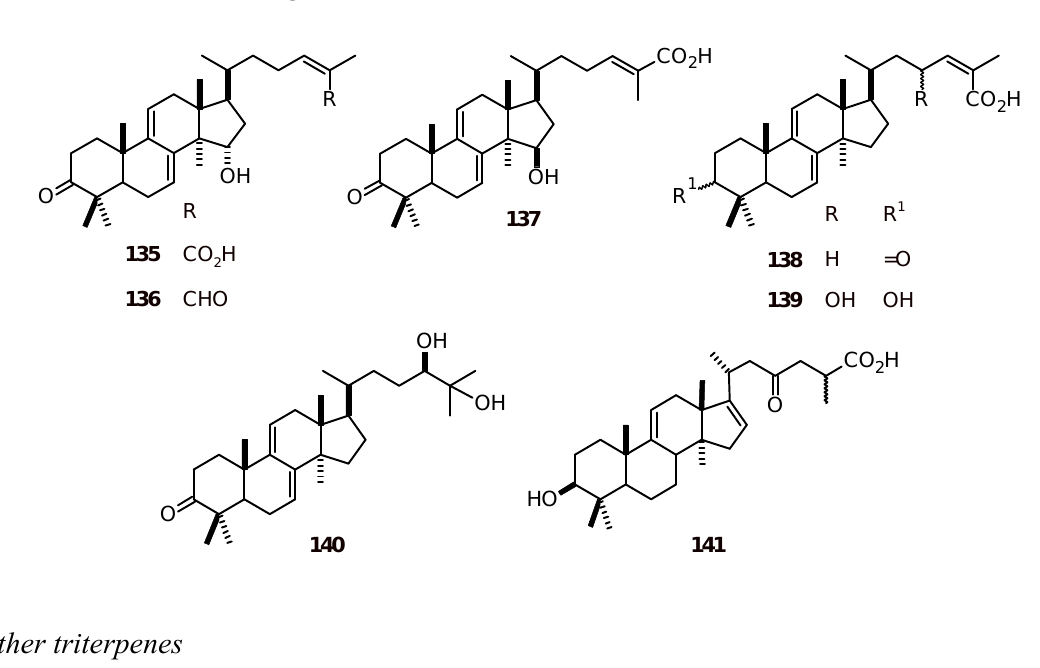
Figure 14. Structures of lanostanes 135 - 141